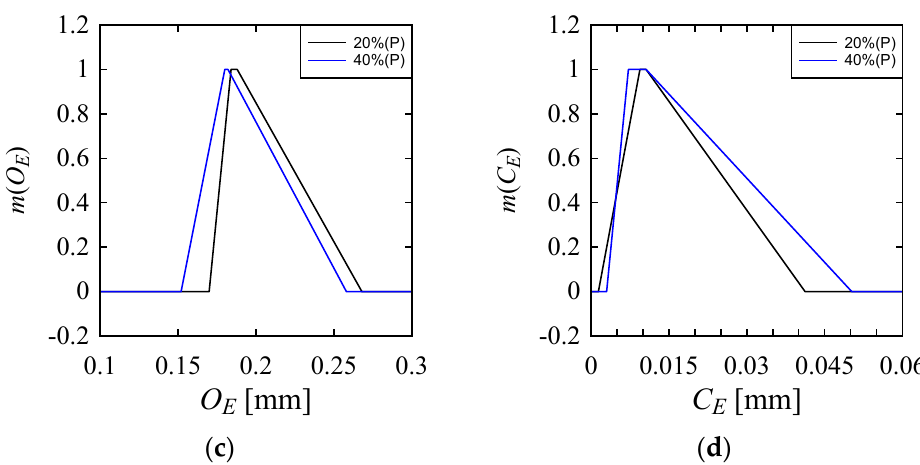
Figure 5. Effect of power on the performance parameters ( a ) On Cutting Force ( F C ); ( b ) On Tool Wear ( T W ); ( c ) On Over Cut Error ( O E ); ( d ) On Cylindricity Error ( C E ).